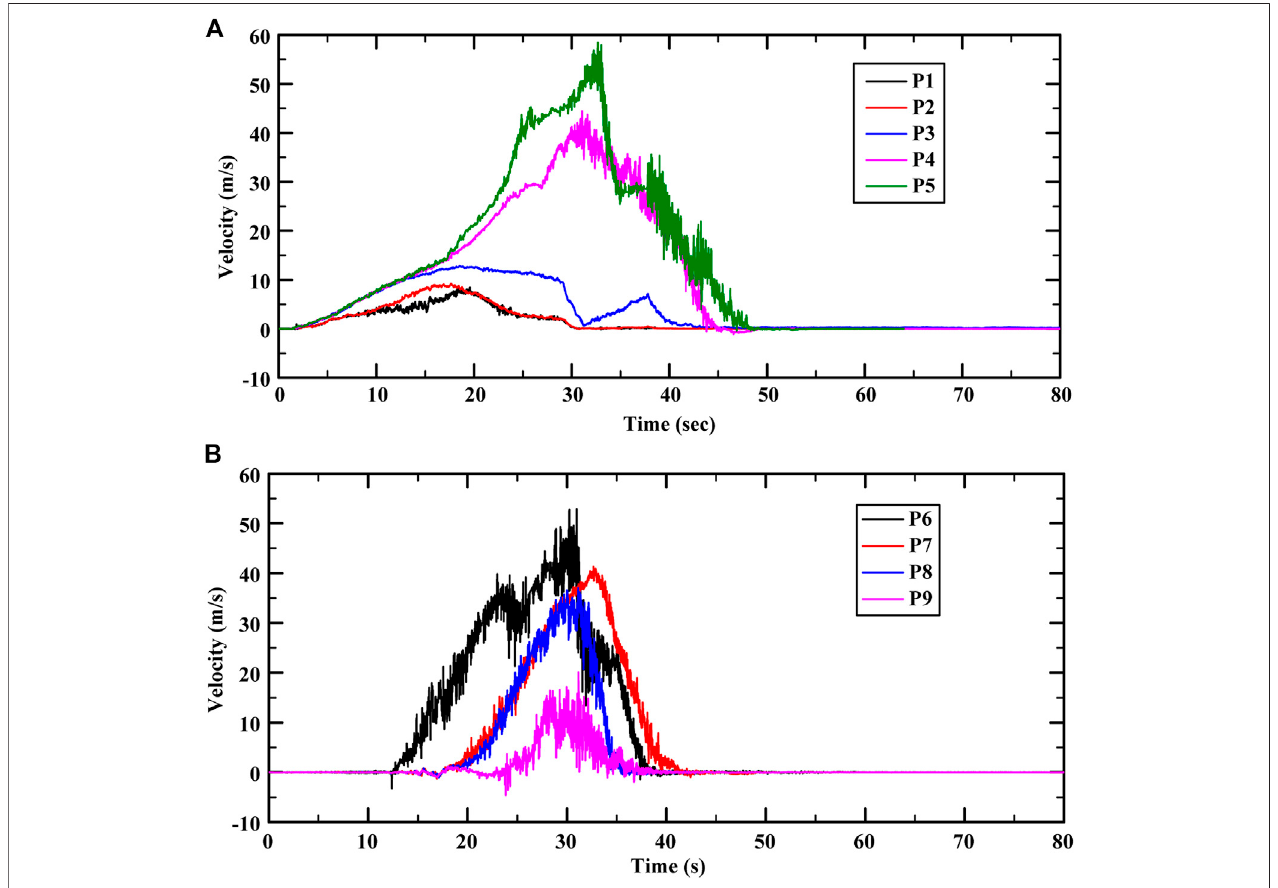
FIGURE11| Time-historycurvesofhorizontalvelocityformonitoringpoints. (A) Velocitiesofmonitoringpointsintheuppersourcearea. (B) Velocitiesofmonitoring points in the Quaternary colluvial and eluvial deposit.